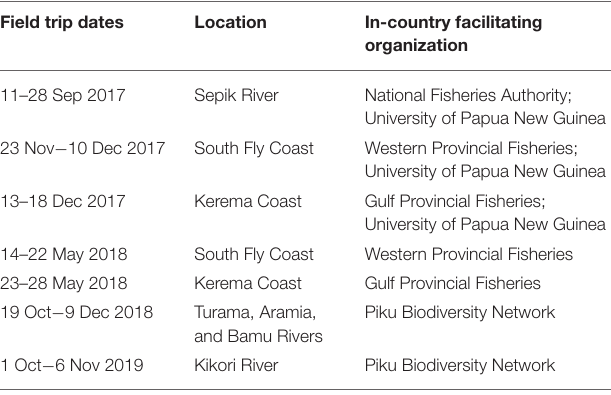
TABLE 1 | Dates, locations, and in-country partners that assisted on each survey trip.